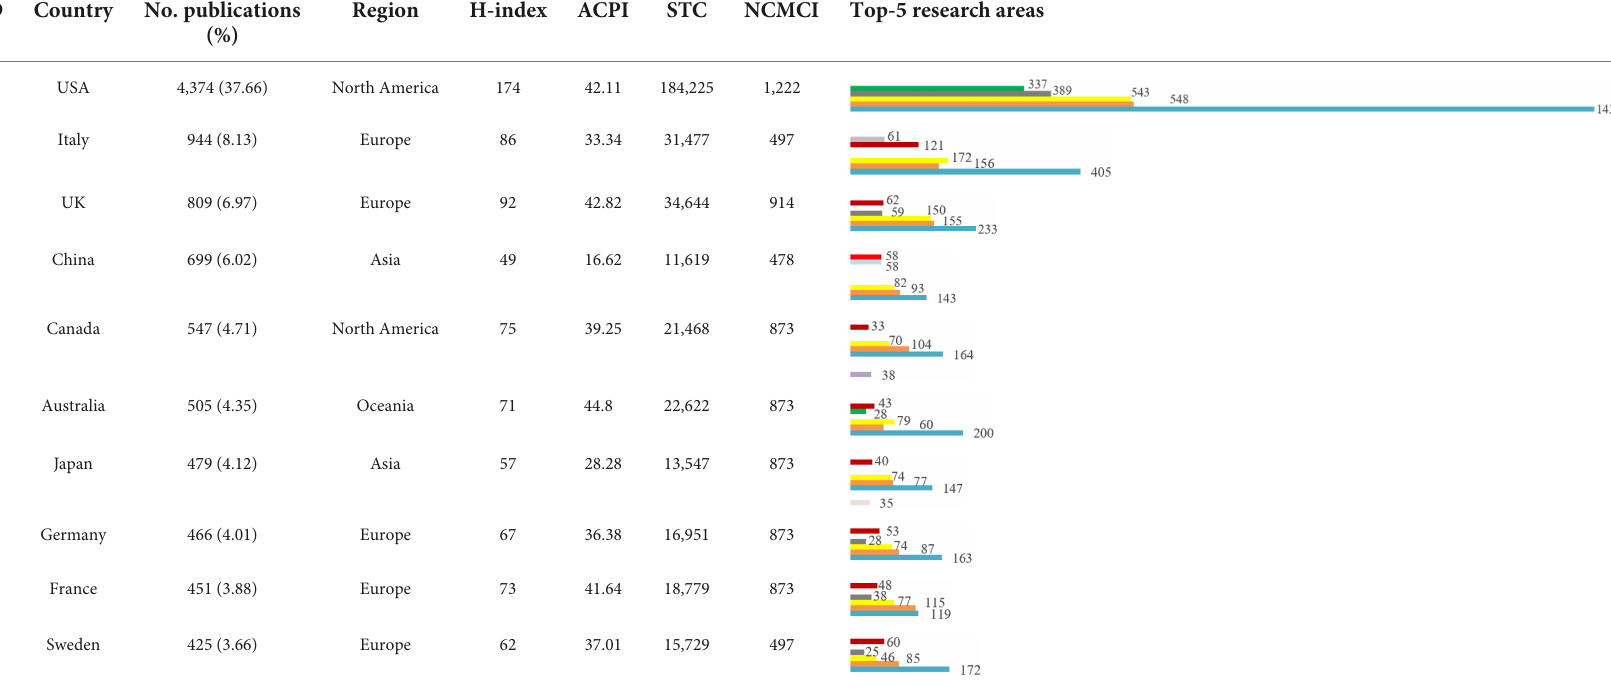
TABLE 2 Characteristics of the top-10 countries ( N =